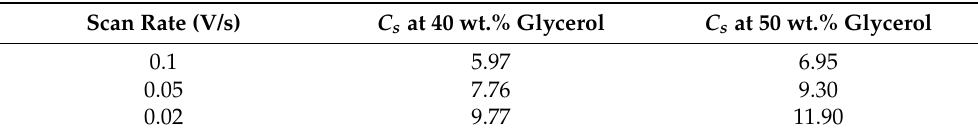
Table 4. C s at differentscan rates for the BGNN4 system (40 wt.% glycerol) and the BGNN5 system (50 wt.%